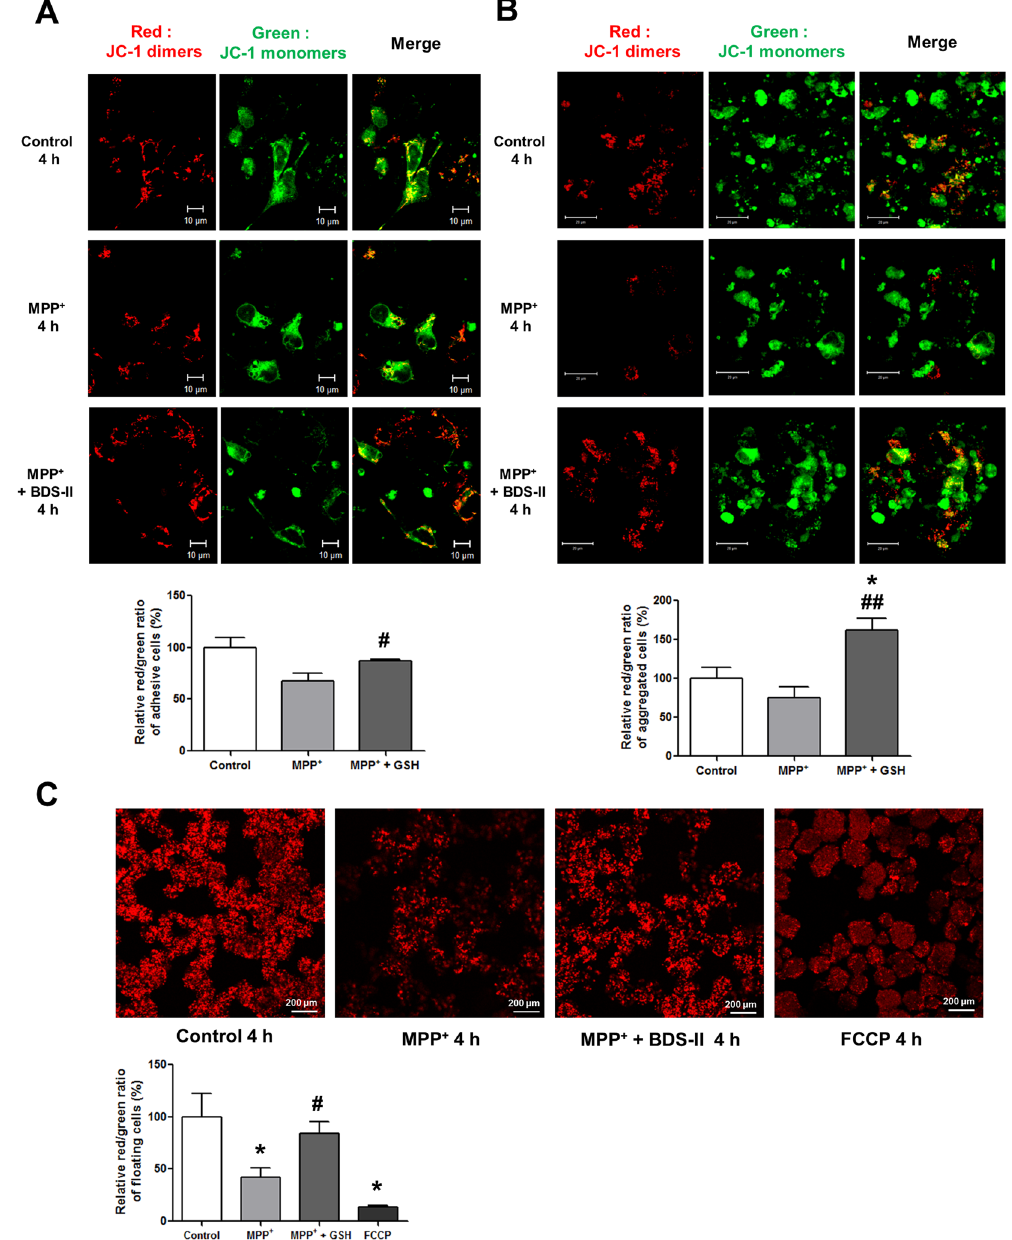
Figure 7. BDS-II blocked MPP + -induced MMP depolarization in SH-SY5Y cells ( A ) JC-1 staining revealed that BDS-II prevented the depolarization of mitochondrial membrane potential induced by 1 mM MPP + in SH-SY5Y cells. Red JC-1 dimers represent normal mitochondrial membrane potential. Green JC-1 monomers represent depolarized mitochondrial membrane potential. Red dimers and green monomers were co-localized in control cells. When cells were treated with 1 mM MPP + , most of the cells showed only green monomers. When we pretreated with 100 nM BDS-II for 10 min followed by 4 h of 1 mM MPP + and 100 nM BDS-II treatment, red dimers and green monomers co-localized again, but many cells also exclusively exhibited red dimers. ( B ) SH-SY5Y cells can form aggregates of undifferentiated cells. BDS-II also prevented the depolarization of mitochondrial membrane potential induced by 1 mM MPP + in aggregated SH-SY5Y cells. Red dimers and green monomers were detected in the control and MPP + + BDS-II groups, whereas almost all of the red dimers disappeared in the MPP + group. ( C ) SH-SY5Y cells also grew into floating clumps of cells. Red JC-1 dimers indicated that 100 nM BDS-II rescued SH-SY5Y cells from MMP depolarization induced by 1 mM MPP + treatment. FCCP (100 µ M) was used as a positive control. All of the experiments were performed in triplicate or quadruplicate, and representative images are